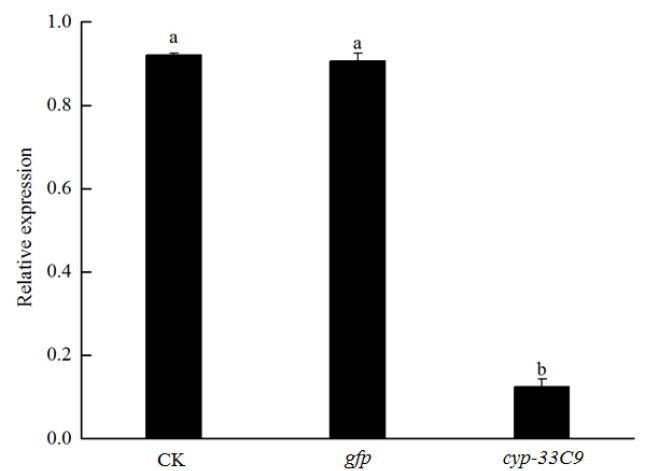
Figure 5. Quantitative reverse transcription PCR analysis of the RNA interference e ffi ciency in Bursaphelenchus xylophilus after treatment with ddH 2 O or dsRNA ( gfp or cyp-33C9 ). The bars indicate standard deviation, and di ff erent letters indicate significant di ff erences ( p < 0.05), according to Tukey’s test, among treatments.